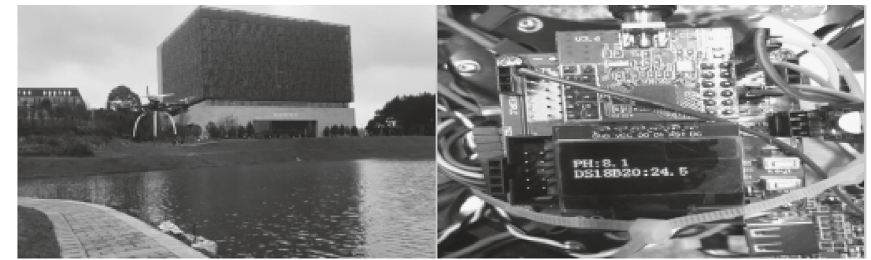
Figure 15: Physical image of UAV test. Table 3: Test results of communication quality.